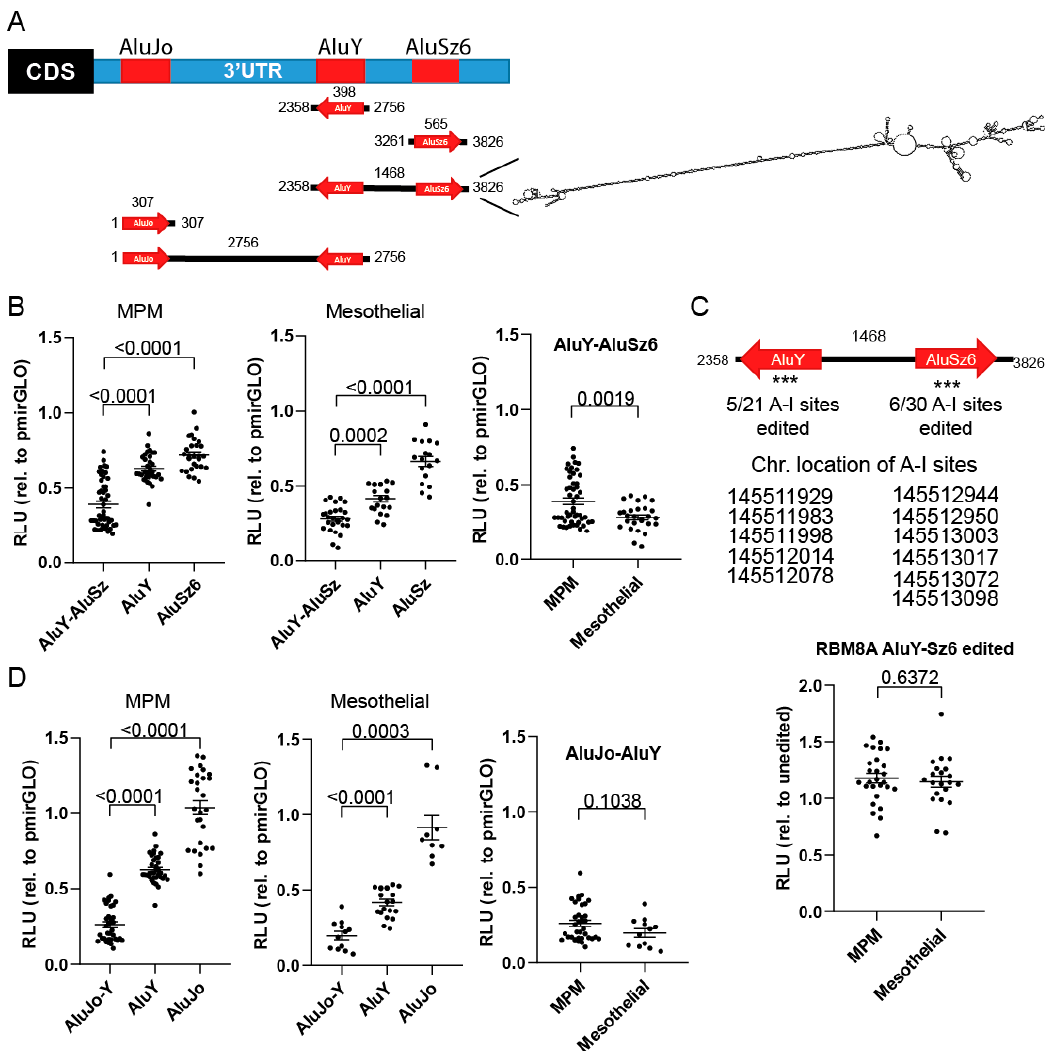
Figure 4. Expression of RBM8A 3 ′ UTR reporter genes in MPM vs. mesothelial cells reveals destabilizing factors binding to it. ( A ) Left panel: structure of the single AluJo, AluY, and AluSz6 or paired AluY and AluSz6 and paired AluJo and AluY inverted elements that were cloned in the miRGlo expression vector. Right panel: the dsRNA structure of the AluY-AluSz6 sequence, which is also identified in Figure 2E, obtained using the ViennaRNA software. ( B ) Relative luciferase intensity after transient transfection of the AluY, AluSz6, and paired AluY and AluSz6 in MPM or mesothelial cells, ANOVA test. ( C ) Upper panel: paired AluY and AluSz6 element with 11 A > G mutations cloned in the miRGlo expression vector. Lower panel: relative luciferase intensity after transient transfection of the reporter in MPM or mesothelial cells. Unpaired t -test. ( D ) Relative luciferase intensity after transient transfection of the AluJo, AluY, and paired AluJo and AluY reporters in MPM or mesothelial cells expressed relative to miRGlo luciferase activity. Unpaired t -test. ***: location of edited